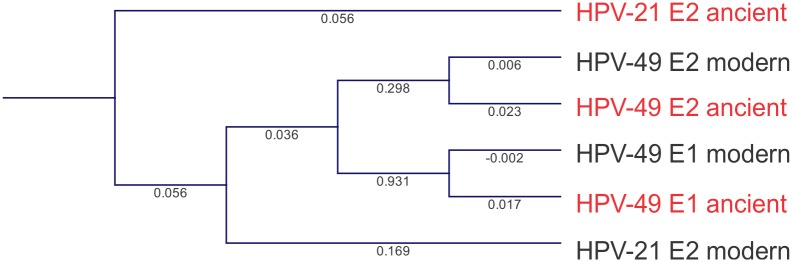
Phylogenetic reconstruction of ancient and extant HPV types 21 and 49 E1 and/or E2.Analyses were performed using maximum likelihood phylogeny using Neighbor Joining, and Jukes Cantor distance with bootstrap resampling (100 replicates). Branch lengths are shown.